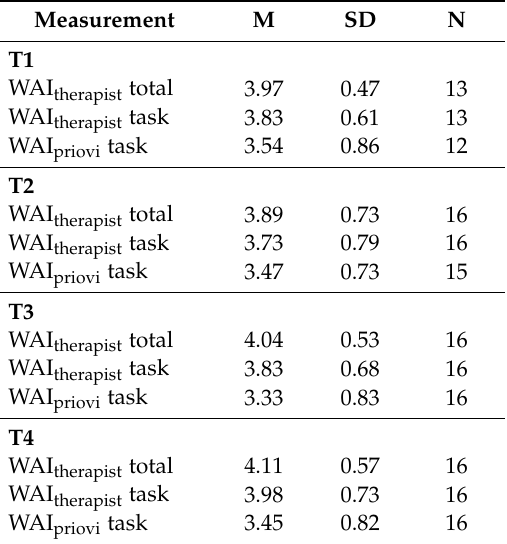
Table 3. Overview of mean scores for WAI therapist and WAI priovi for four measurement states. Measurement